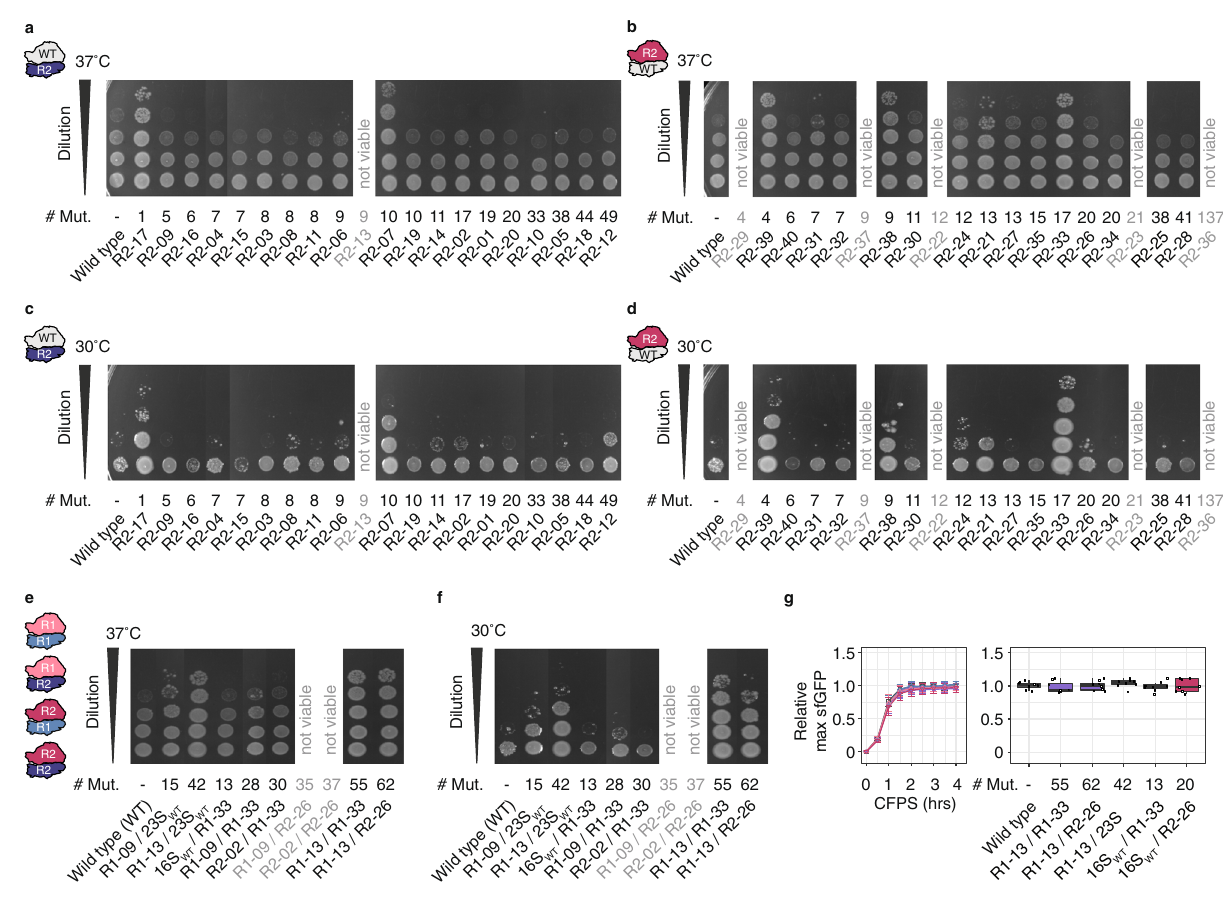
Fig.5|EternadiscoversdiverserRNAswhicharefunctionalinvivo.a – f Spotted SQ171fg cells growing with pL-rrnB-WT and pL-rrnB-R2 16S rRNA ( a , c ) 23S rRNA ( b , d ), and combinatorial 16S/23S rRNA designs imaged after 24h at 37 °C ( a , b , e ) or 72h at 30°C ( c , d , f ). Stationary cells were diluted to an OD600= 1, diluted stepwise 1:10, and spotted onto LB+ Carb 100 plates. Mut.: